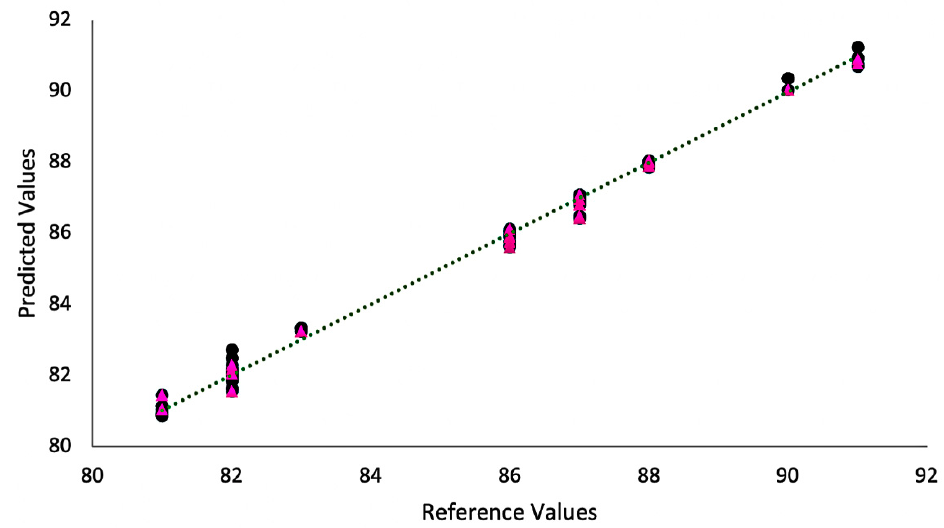
Figure 3. Experimental (black circles) vs. predicted values (pink triangles) obtained by the models based on FTIR spectra.